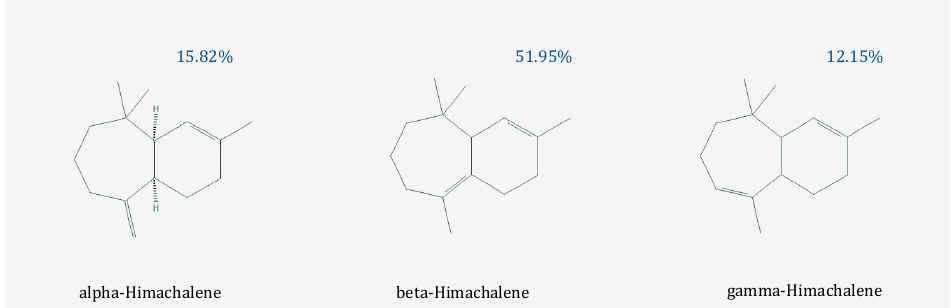
Figure 2. Cedar wood major compounds.